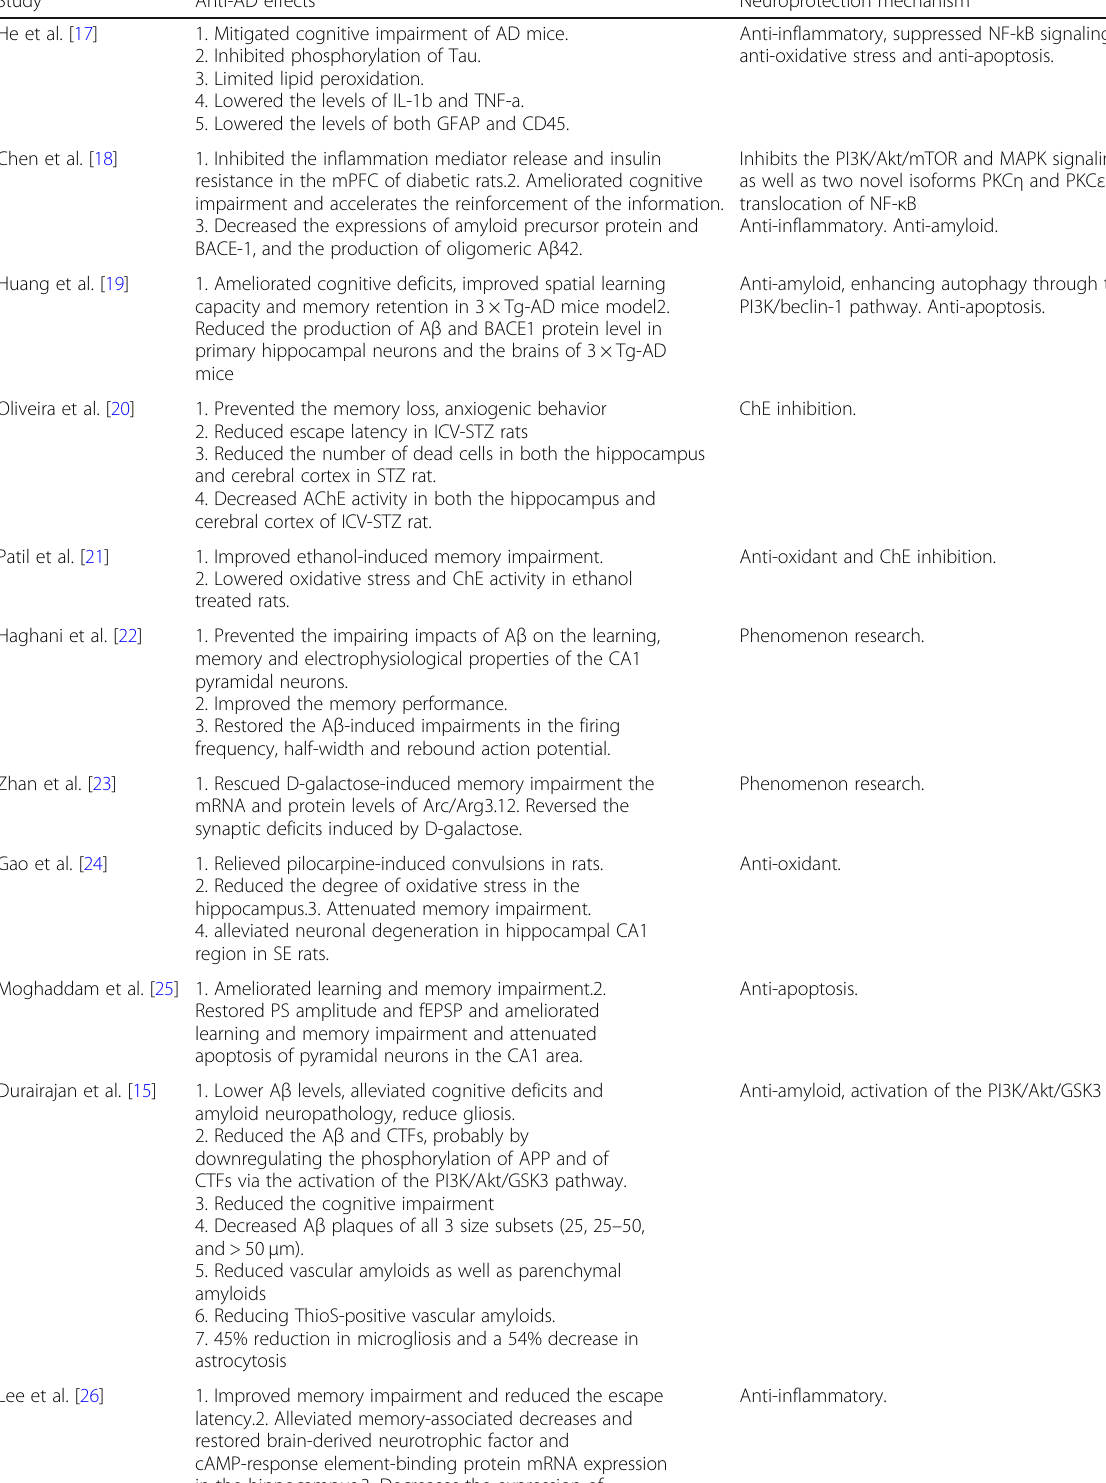
Table 3 Anti-AD effects and underlying mechanisms after berberine treatment of included studies